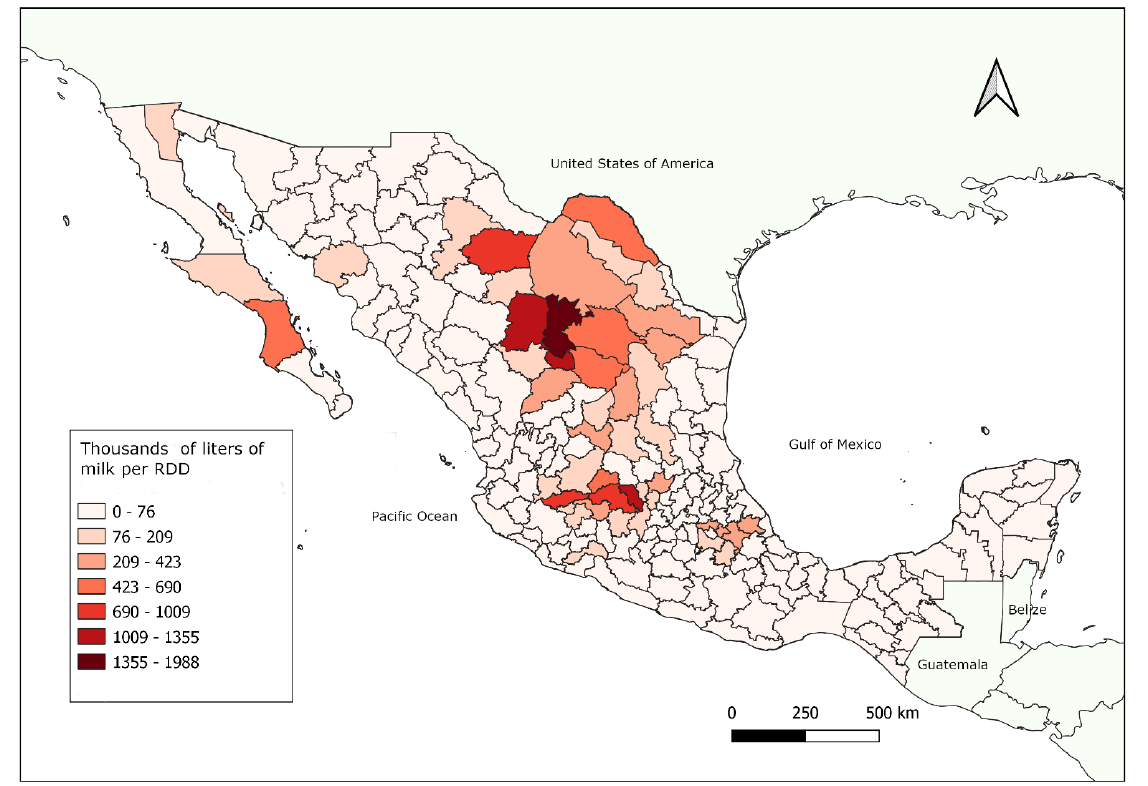
Figure 3. Distribution of goat milk production in Mexico by Rural Development Districts (RDD, or DDR for its acronym in Spanish). Notably, milk production under semi-intensive and intensive systems is mainly in central and north Mexico. These systems are near large cities, have easy access to technical support from veterinarians, and have close access to points of sale. The Secretariat of Agriculture and Rural Development divides Mexico into 191 districts, according to geographic, social, and environmental factors that promote connection between the state, local farmers, and municipalities.